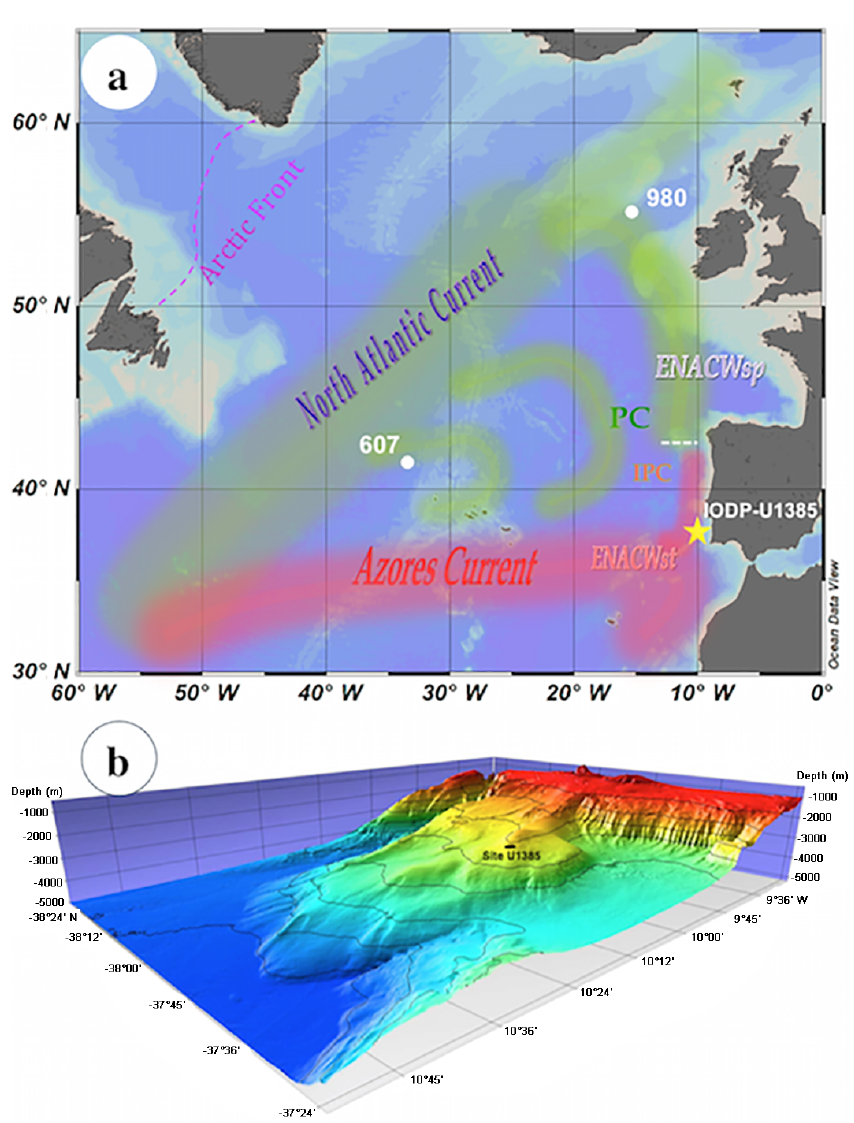
Figure 1. (a) Modern surface circulation in the North Atlantic and location of IODP-U1385 and other sites discussed in this paper. ENACWsp: eastern North Atlantic Central Water of subpolar origin; ENACWst: eastern North Atlantic Central Water of subtropical ori- gin; IPC: Iberian Poleward Current; PC: Portugal Current. The white dashed line represents the today’s approximate surface limit between ENACWsp and ENACWst (Fiúza et al., 1998). (b) Regional bathymetry of the southwest Iberian margin, showing site U1385 (Expedition 339 Scientists,